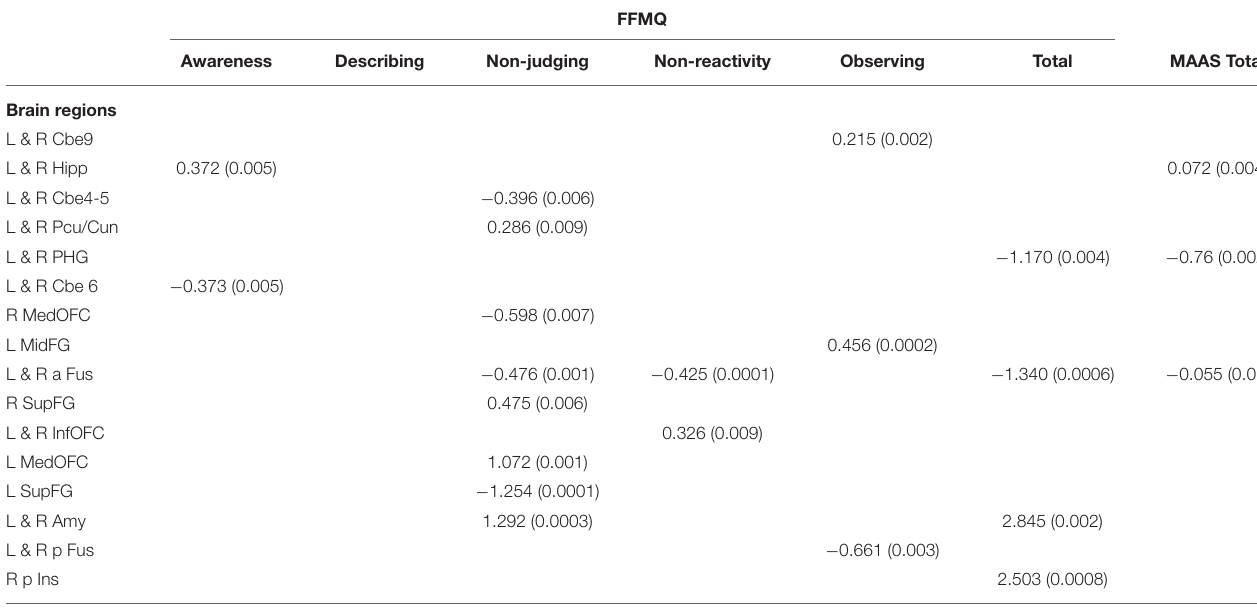
TABLE 1 | Correlations between FFMQ, MAAS, and DERS dimensions. FFMQ MAAS total Awareness Describing Non-judging Non-reactivity Observing − 0.153 − 0.367 − 0.021 − 0.380 − 0.359 − 0.257 DERS Emotional awareness Emotional clarity − 0.410 − 0.554 − 0.284 − 0.445 − 0.243 − 0.391 − 0.440 − 0.277 − 0.305 − 0.299 − 0.134 − 0.304 Goal–directed behavior Impulse control − 0.367 − 0.332 − 0.394 − 0.366 − 0.133 − 0.356 Non–acceptance − 0.290 − 0.090 − 0.501 − 0.181 0.041 − 0.308 Strategies − 0.438 − 0.326 − 0.501 − 0.417 − 0.121 − 0.406 Shaded cells indicate significance after FDR correction.